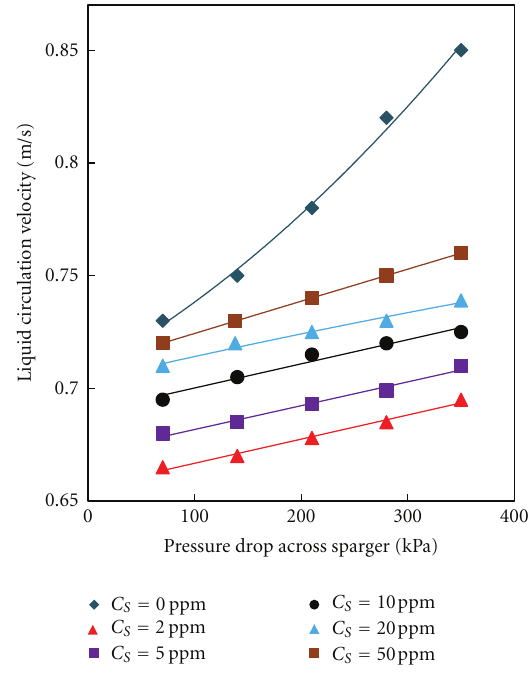
Figure 12: E ff ect of superficial Gas velocity on liquid circulation rates in rapidly coalescent systems ( C S = 0ppm, W L = 0 . 06 kg/s). place in the separator design adopted in the present inves- tigation and few bubbles were observed to be entrained into the downward recirculating stream (Figure 5).